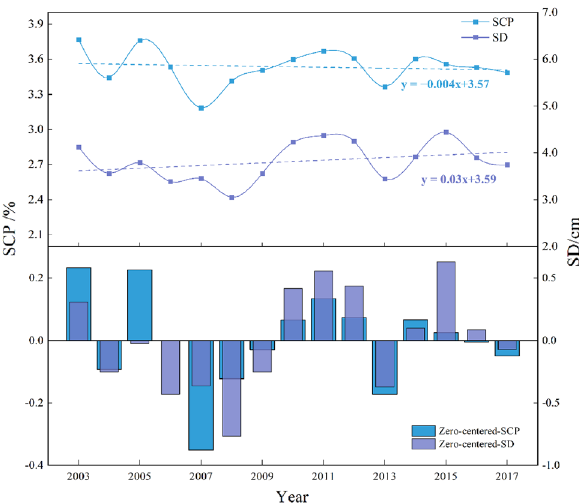
Figure 3. Interannual variation in SCP/SD.